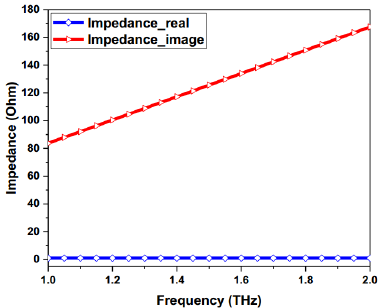
Figure 2. Impedance curve of the graphene with the specified parameters. The real part and imaginary part of the graphene’s impedance vary in the range of the 1 ~2 THz frequency